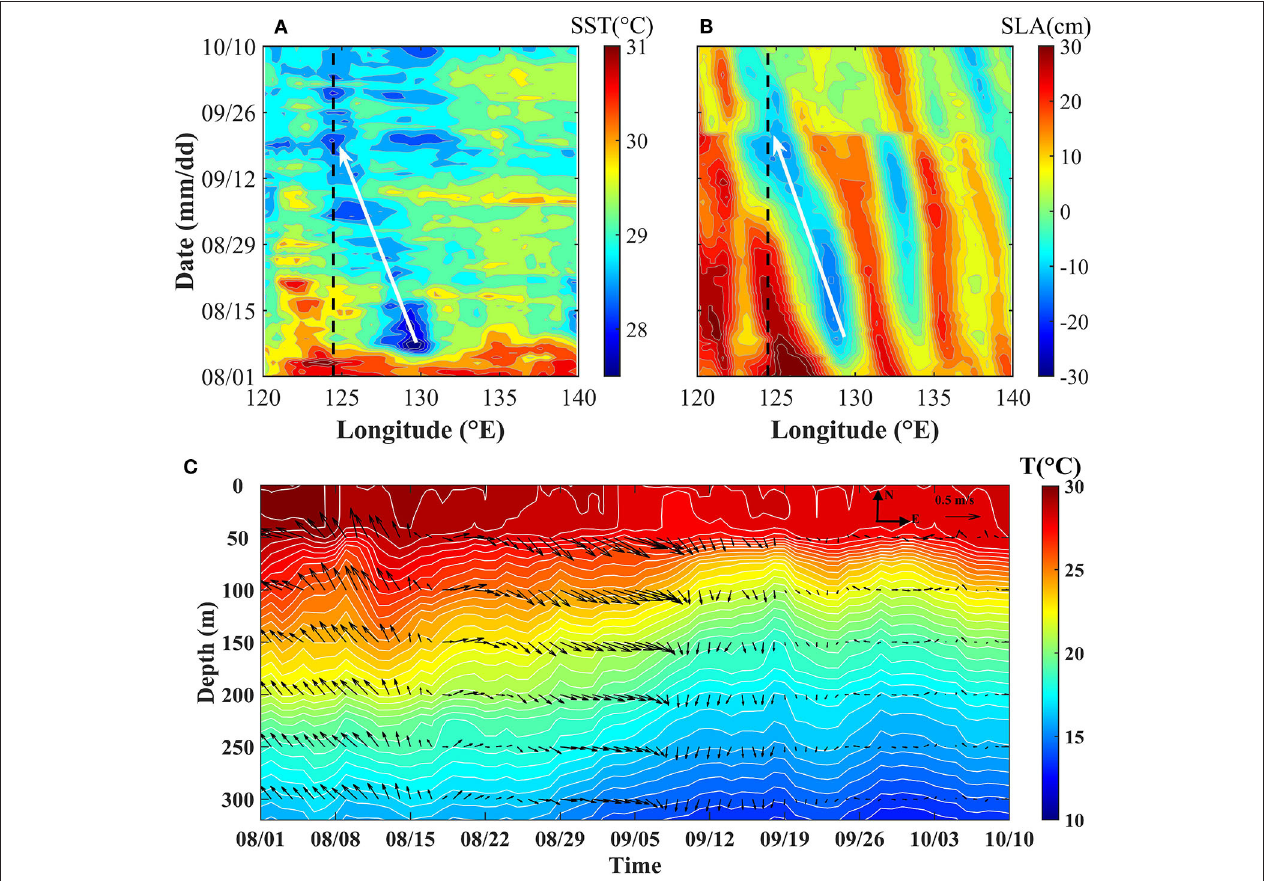
FIGURE 8 | Time-longitude diagram of the (A) SST and (B) sea-level anomaly along 20 ◦ N; (C) vertical profiles of temperature and velocity at the wave-glider position. SST, sea surface